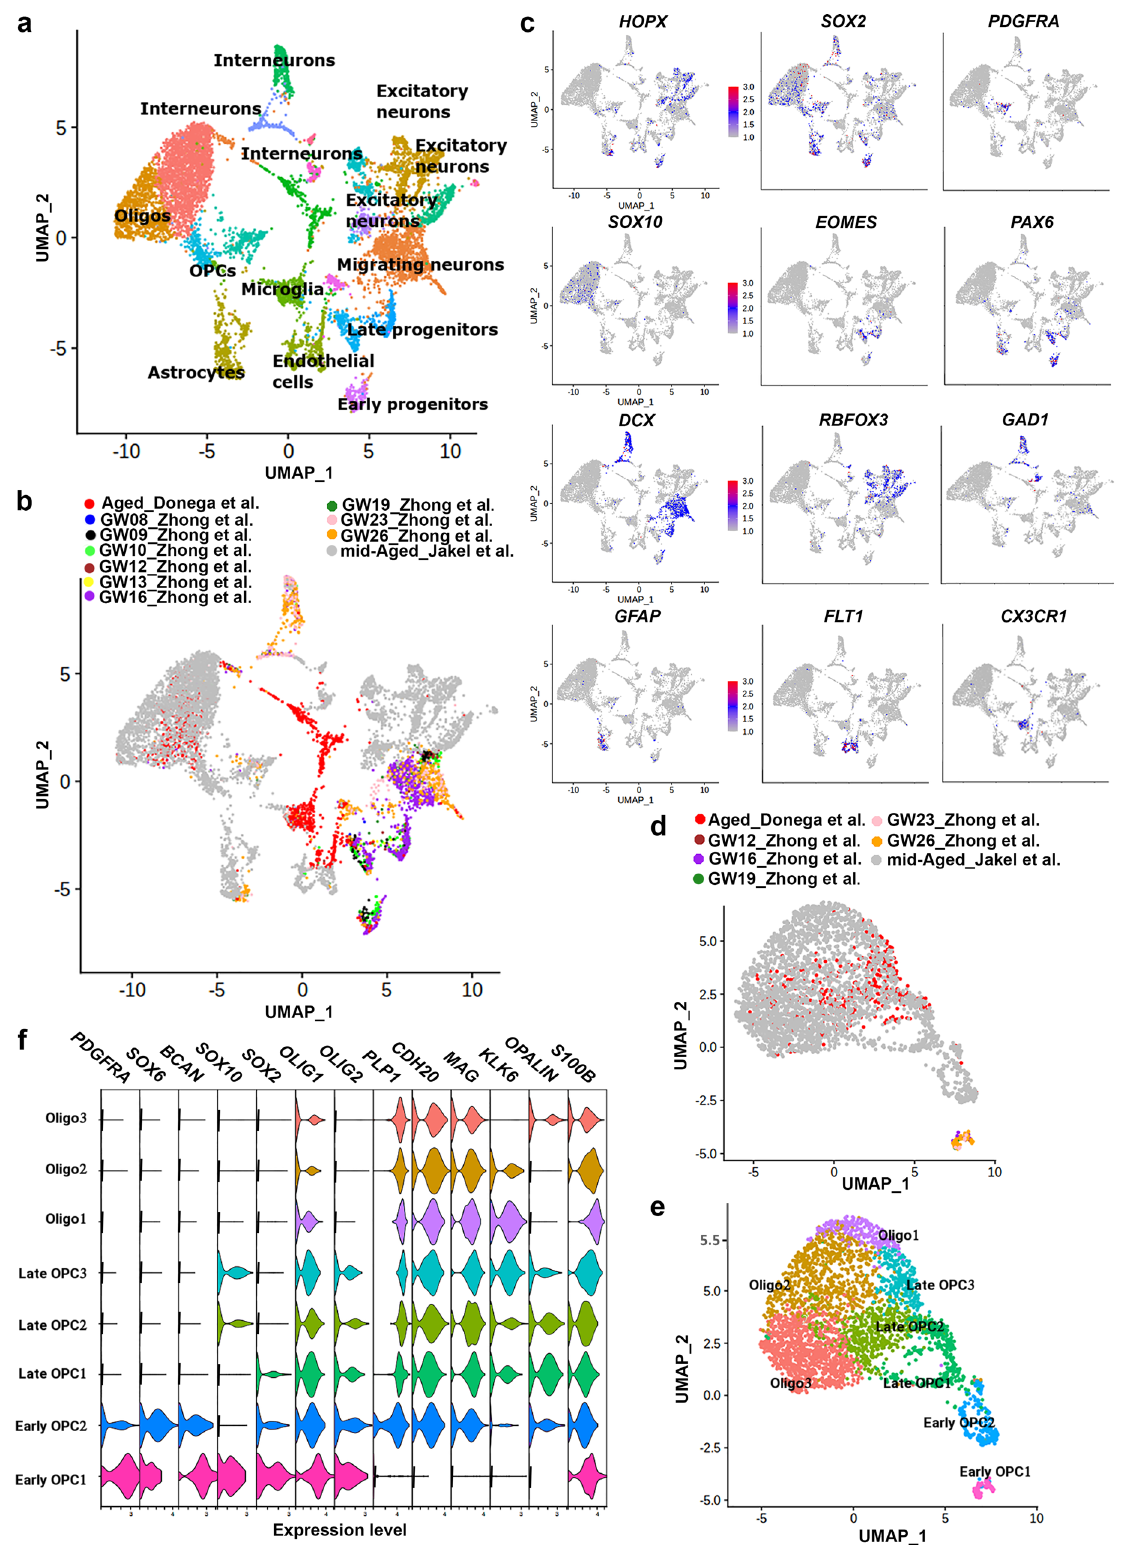
Fig. 2 CD271 + cells correspond to late OPCs and oligodendrocytes. a , b UMAP projection of cell clusters shown by cell population ( a ) and origin of individual cells ( b ). c Feature plots for canonical markers of different cell populations. d , e UMAP projection of the origin of individual cells ( d ) and OPC lineage subclusters ( e ). f Violin plots of markers enriched in speci fi c oligodendrocyte subpopulation. Gene expression level plotted as normalized counts. GW gestational weeks. ( n = 3 donors; 2 females, aged 95 (504 cells) and 96 years (118 cells); 1 male, aged 72 years (116